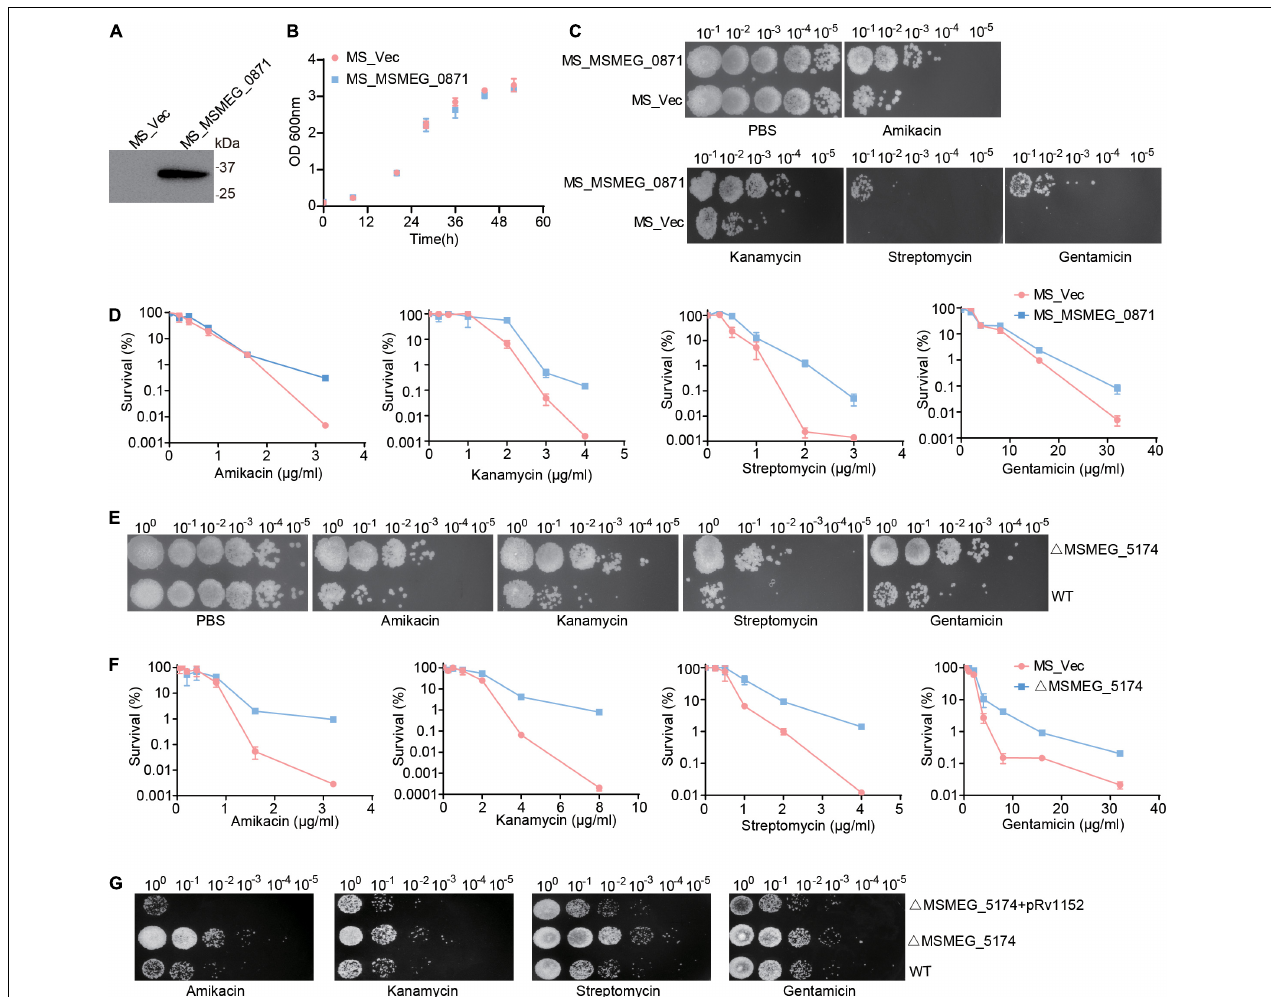
FIGURE 3 | MSMEG_5174 deficiency blocks aminoglycoside antibiotics mediated bacterial killing. (A) The exogenous expression of MSMEG_0871 in M. smegmatis . (B) The growth of MS_Vec and MS_MSMEG_0871. (C) MS_Vec and MS_MSMEG_0871 were treated with indicated concentration of aminoglycoside antibiotics. (D) MS_Vec and MS_MSMEG_0871 were treated with different concentration of aminoglycoside antibiotics. (E) WT and (cid:49) MSMEG_5174 were subjected to indicated concentration of aminoglycoside antibiotics treatment. (F) WT and (cid:49) MSMEG_5174 were treated with different concentration of aminoglycoside antibiotics. (G) WT, (cid:49) MSMEG_5174 and (cid:49) MSMEG_5174 + pRv1152 strains were treated with indicated concentration of aminoglycoside antibiotics.